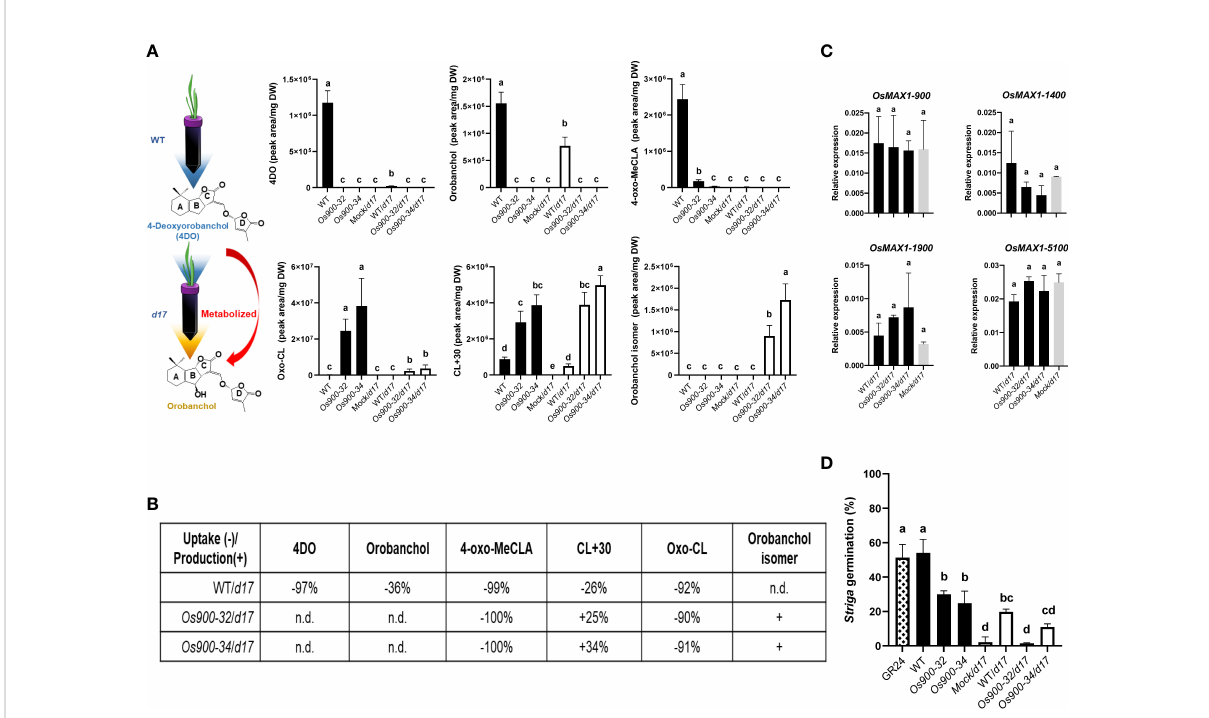
FIGURE 2 Feeding experiments and the metabolism of root-released SLs (A) Illustated scheme of feeding the expreriments and SLs quanti fi cation in the root exudates of WT, Os900-32 and -34 grown hydroponically under low Pi and used as feeding solution for the d17 . 4-oxo-MeCLA (putative methyl 4-oxocarlactonoate), CL+30, 4DO (4-deoxyorobanchol), oxo-carlactone (oxo-CL), orobanchol isomer and orobanchol. The values are the mean ± SD for a number of 3-5 biological replicates. The statistical signi fi cance is determined by one-way ANOVA and Tukey ’ s multiple comparison test. (B) Percentage of SLs conversion: uptake (-) and production (+) by d17 after being fed with readjusted (Pi and pH) exudates from WT, Os900-32 and -34. Percentages indicate how much of the SLs present in the exudates were uptaken (-) by d17 (and not released, like 4DO, orobanchol, 4-oxo-MeCLA isomer and oxo-CL) and produced/released (+) by the d17 such as CL+30 and orobanchol isomer for d17 plants fed with Os900 exudates. (C) Gene expression level of the four functional Nipponbare MAX1 genes in root tissues of 3-week old d17 seedlings after feeding with WT (WT/ d17 ) or Os900-32 , -34 ( Os900-32 / d17 and Os900-34 / d17 ) root exudates, compared to mock (Mock/ d17 ). The values are the mean ± SD number of biological replicates n (3 ≤ n ≤ 4). The statistical signi fi cance is determined by one-way ANOVA